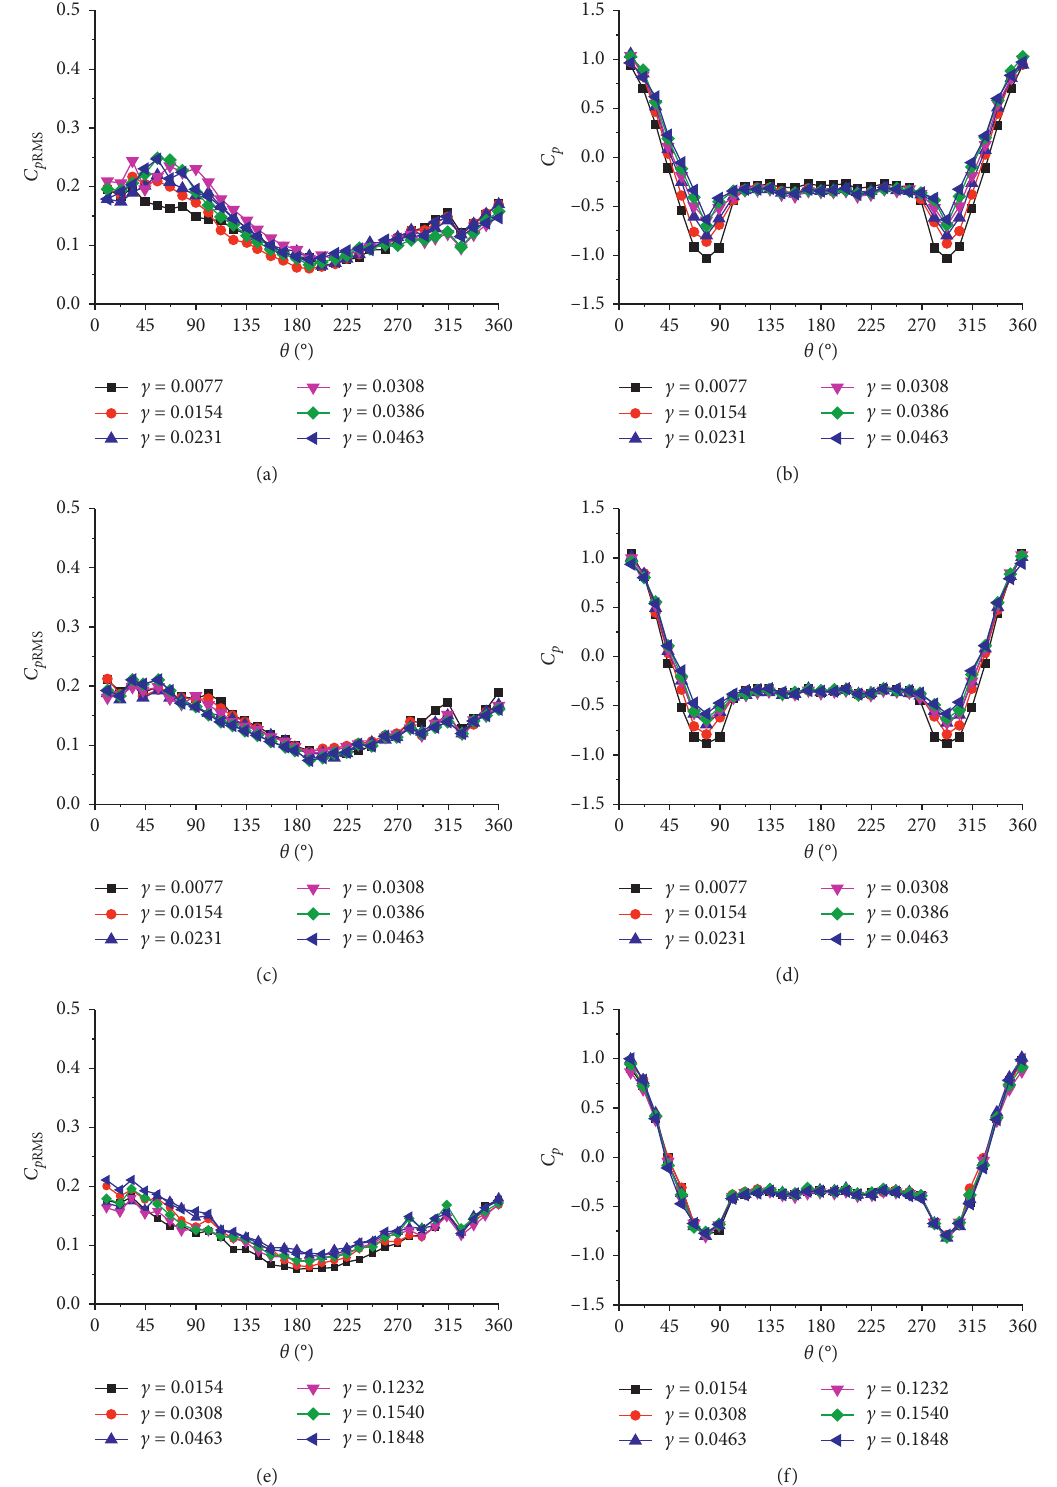
Figure 12: Effects of the spacing ratio on wind pressure distribution. (a, c, e) Fluctuating wind pressure coefficient and (b, d, f) mean wind pressure coefficient. (a, b) c � 0, (c, d) c � 0.0386, and (e, f) c �